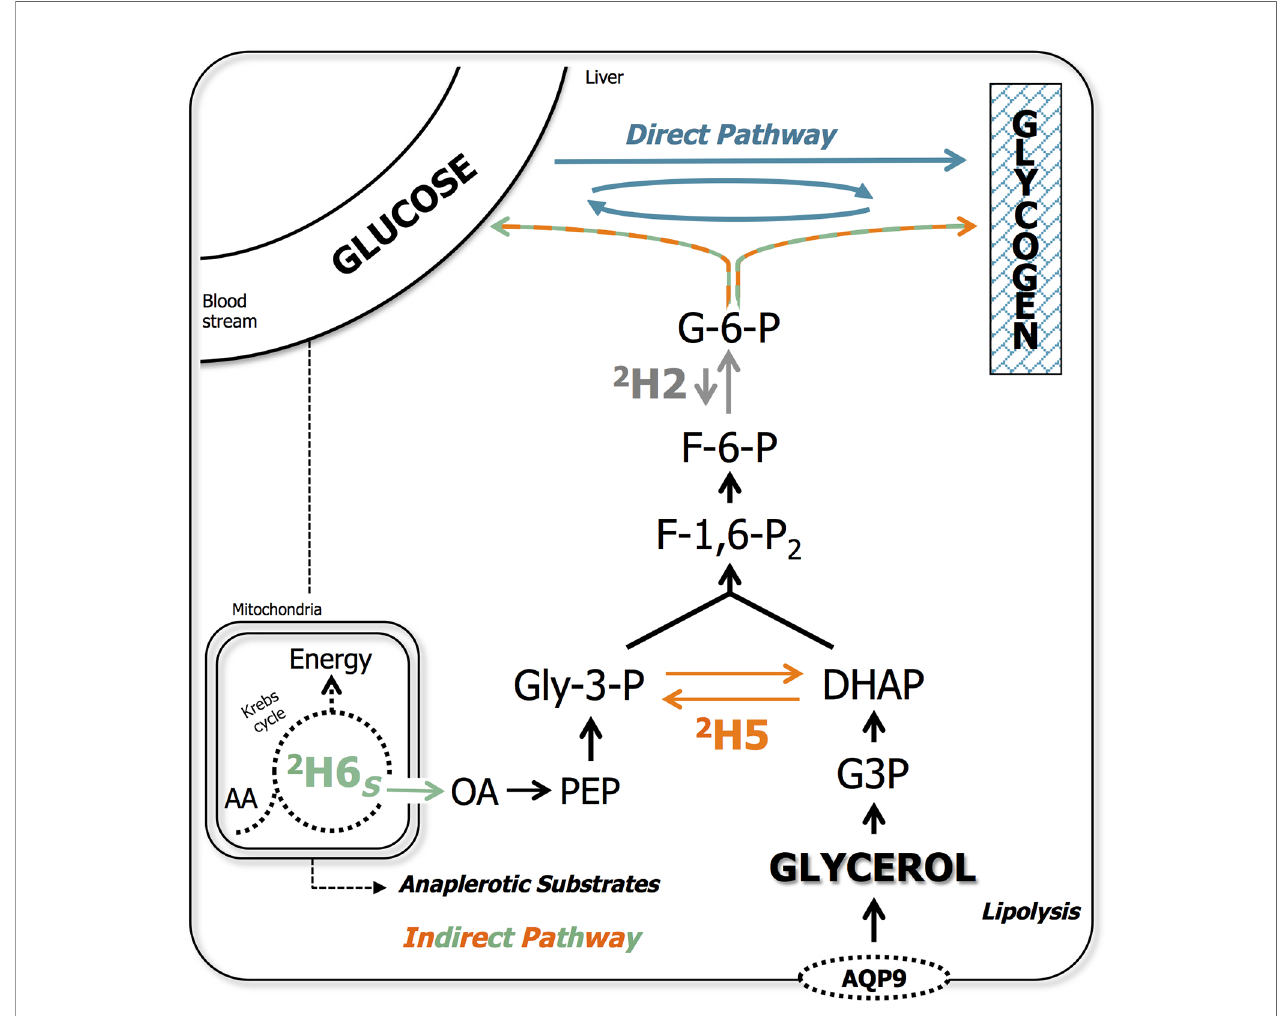
FIGURE 1 | Metabolic model representing metabolic pathways for blood glucose and hepatic glycogen synthesis. Gluconeogenesis/indirect pathway includes: i) precursors that are metabolized via the anaplerotic pathways of Krebs cycle (i.e., pyruvate and glucogenic amino acids); ii) glycerol from lipolysis and imported from the blood stream via aquaporin 9 (AQP9); and iii) pyruvate derived from glucose, as indicated by the dashed arrow. Metabolic model for 2 H-enrichment sites of glucose/glycosyl molecule from 2 H 2 O: position 2 ( 2 H2; in grey) via glucose-6-phosphate isomerase; position 5 ( 2 H5; in orange) via triose phosphate isomerase; and position 6 S ( 2 H6 S ; in green) via fumarase in the Krebs cycle. Several metabolic intermediates were omitted for clarity. G-6-P, glucose-6-phosphate; Gly-3-P, glyceraldehyde-3-phosphate; G3P, glycerol-3-phosphate; DHAP, dihydroxyacetone phosphate; OA, oxaloacetate; PEP, phosphoenolpyruvate; AA, amino